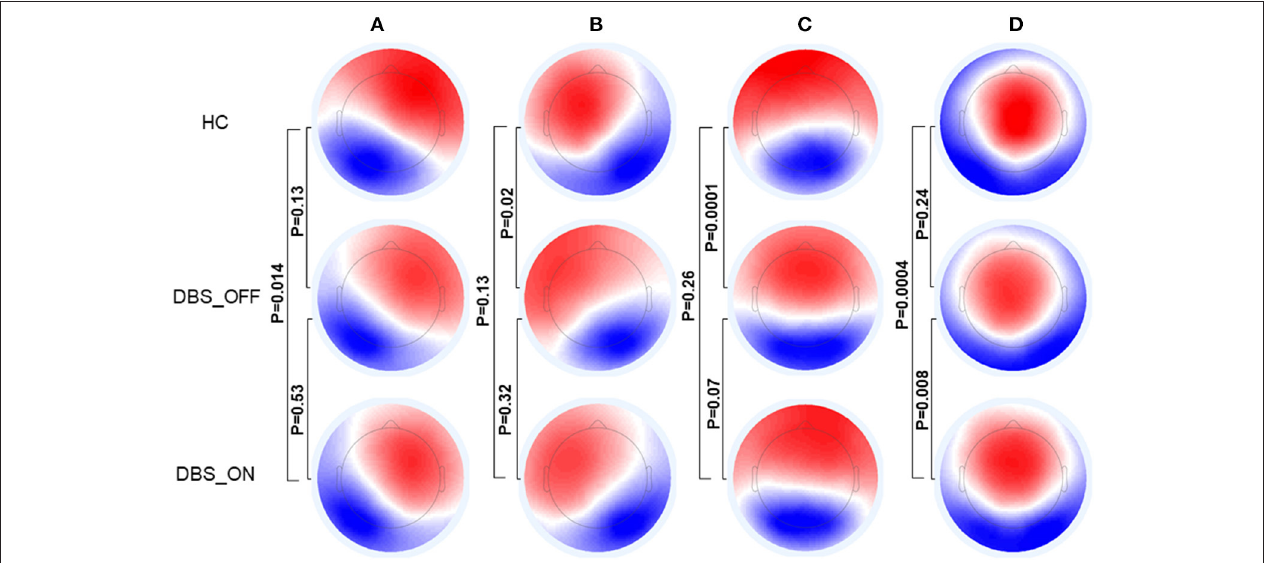
FIGURE 1 | Topographic maps of Microstate (A–D) . The p -values are yielded by comparing the group topographic maps between groups with TANOVA. DBS, deep brain stimulation; HCs, healthy controls; TANOVA, topographical ANOVA.